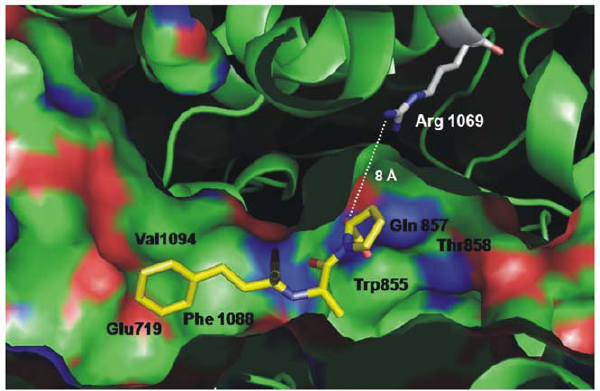
Figure 6. Localization of critical residues in the active center of the C-domain. The localization of amino acid residue Arg1069 relative to the active center of the human ACE C-domain is shown in the ribbon representation of the substrate-bound crystal structure of the C domain fragment in which the 36 amino acid residues unique to tACE have been deleted [75]. Key amino acids referred to in the text crucial for substrate specificity and ACE inhibition are denoted by somatic ACE numbering. Arg1069 is located more than 8 A˚ from the nearest residue (Pro) of ACE inhibitor enalaprilat shown in yellow.